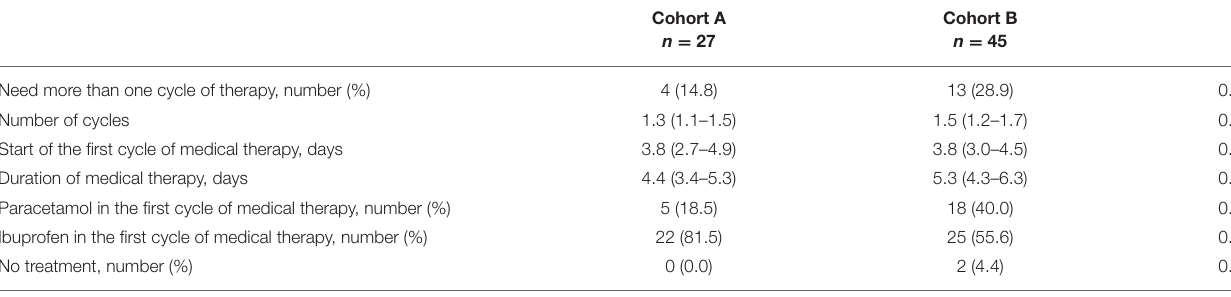
TABLE 5 | Pharmacological treatment in the two study cohorts.